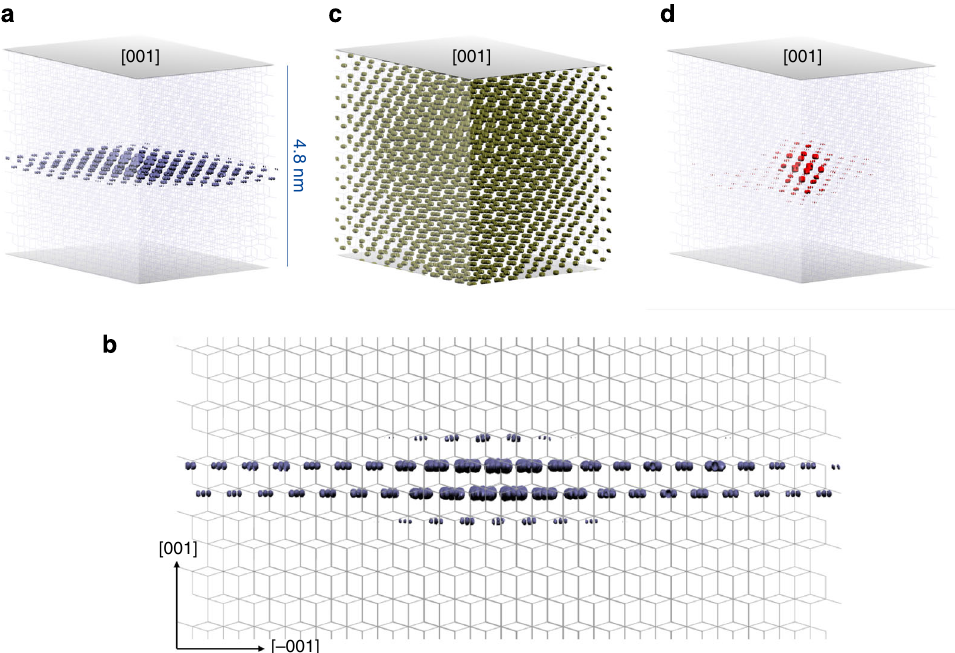
Fig. 7 Wavefunctions of the fundamental charge excitations in anatase TiO 2 . Isosurface representation of the electronic con fi guration when the hole of the considered excitonic pair is localised close to one oxygen atom. The coloured region represents the excitonic squared modulus wavefunction. a Bound exciton I at 3.76 eV. b Side-view of the bound exciton I at 3.76 eV. c Resonance II at 4.37 eV. d Bound exciton III at 4.28